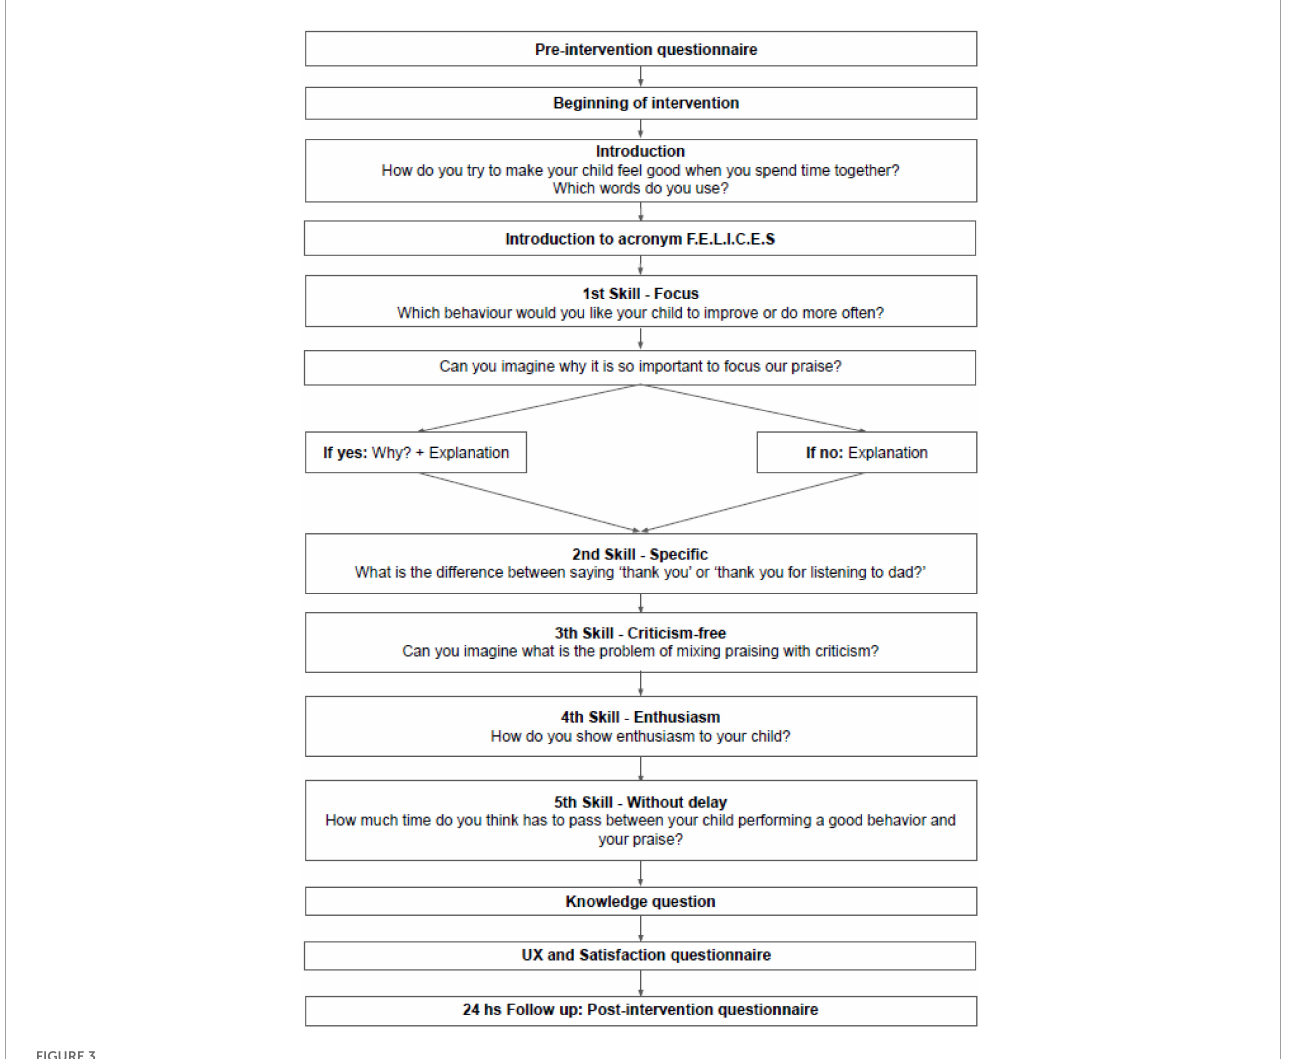
FIGURE3 Intervention